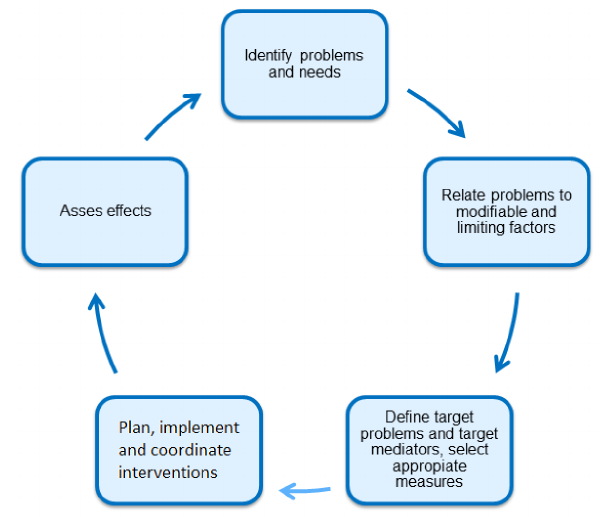
Figure 1. Rehabilitation